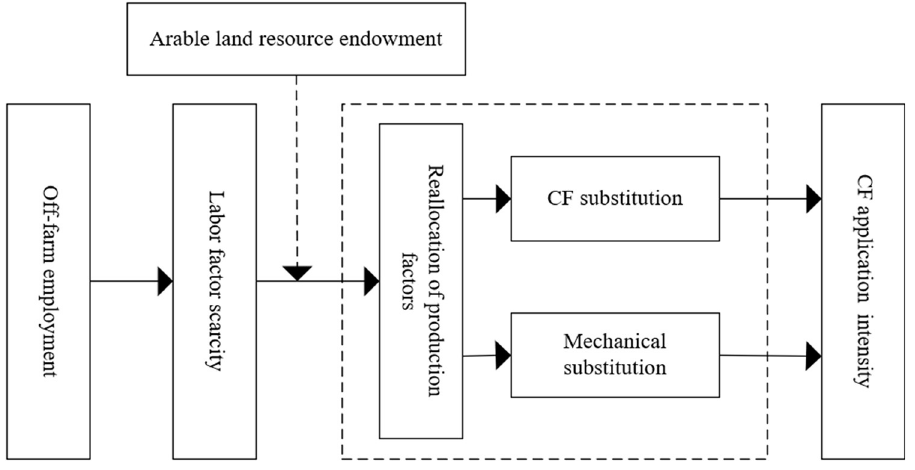
Fig 1. Theoretical framework analysis. Source: The authors’